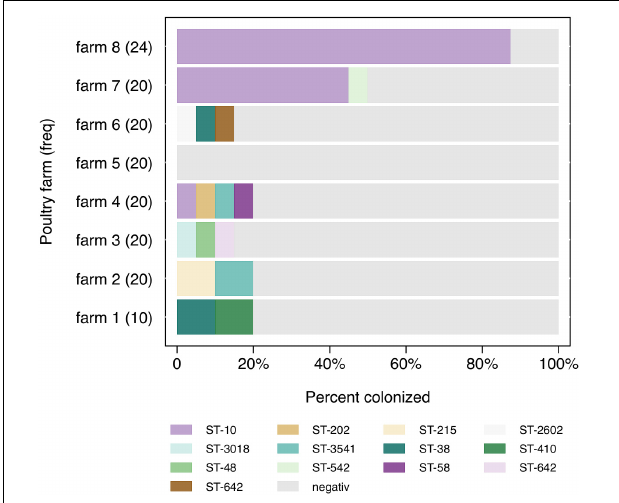
FIGURE 1 | Distribution of ESBL-producing Escherichia coli sequence types (ST) ( n = 45) among farms.